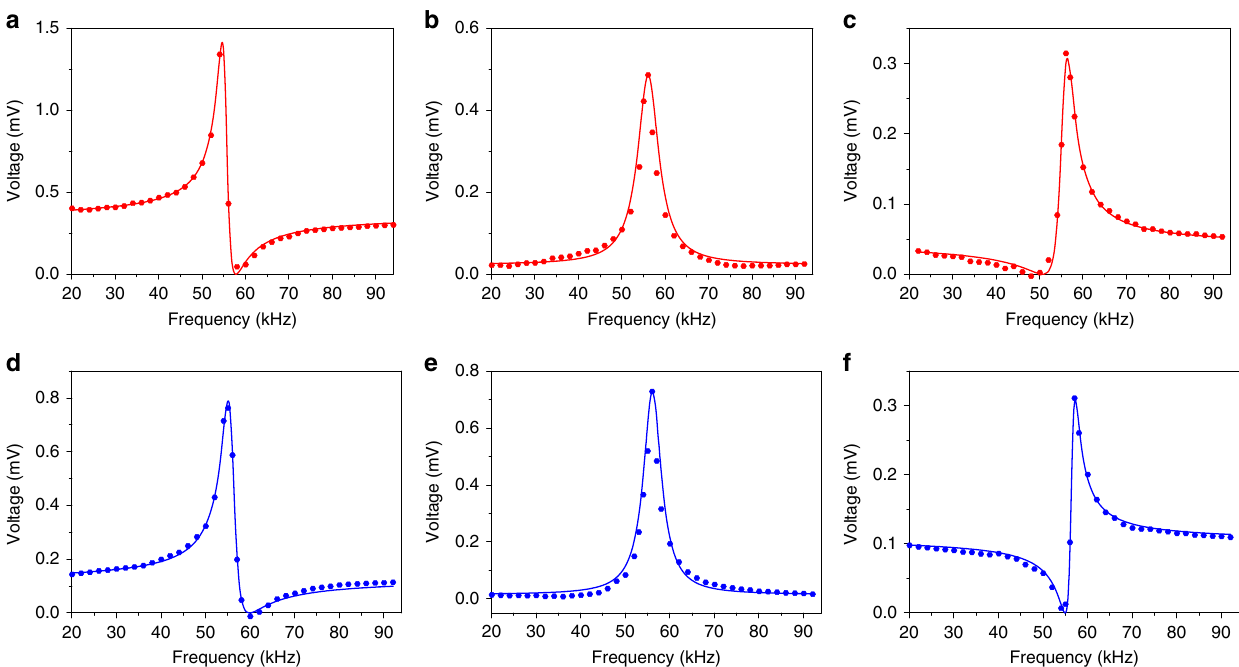
Fig. 3 Representation of anti-resonance effect of ME output voltage. a – c ME output voltage of hot-press sample as a function of H ac frequency under a H dc = 4.2 Oe, b H dc = 10.8 Oe, and c H dc = 12.8 Oe. d – f ME output voltage of air-dried sample as a function of H ac frequency under d H dc = 3.9 Oe, e H dc = 5.9 Oe, and f H dc = 12.7 Oe. The experimental data ( dots ) are fi tted to a modi fi ed Maxwell Eq. 4 or Lorentzian function (shown as solid lines